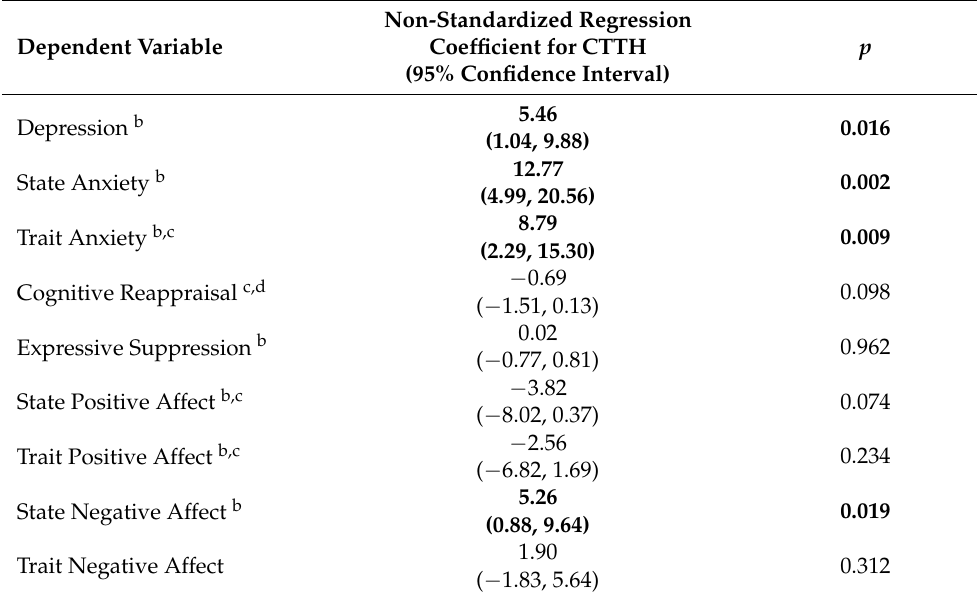
Table 4. Associations (multivariate analysis a ) between CTTH and psychological